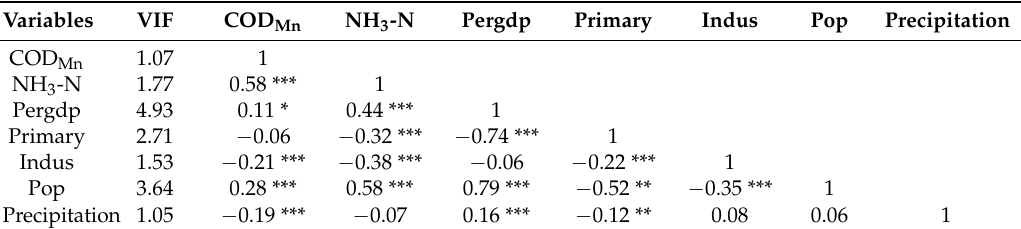
Figure 2. Spatial pattern diagram of water-environment quality. Table 2. Correlation coefficient matrix and Variance Inflation Factor (VIF)